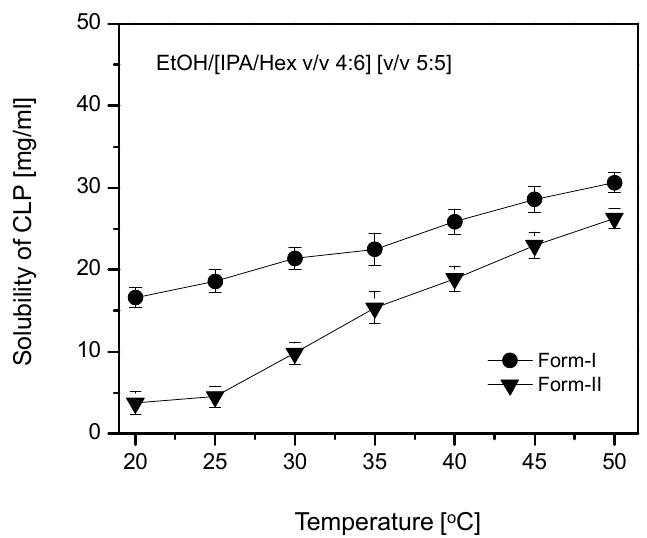
Figure 8. Solubility of CLP Forms I and II as a function of temperatures when IPA/Hex was used as an anti-solvent. Form II shows lower solubility than Form I over the temperature ranges studied.